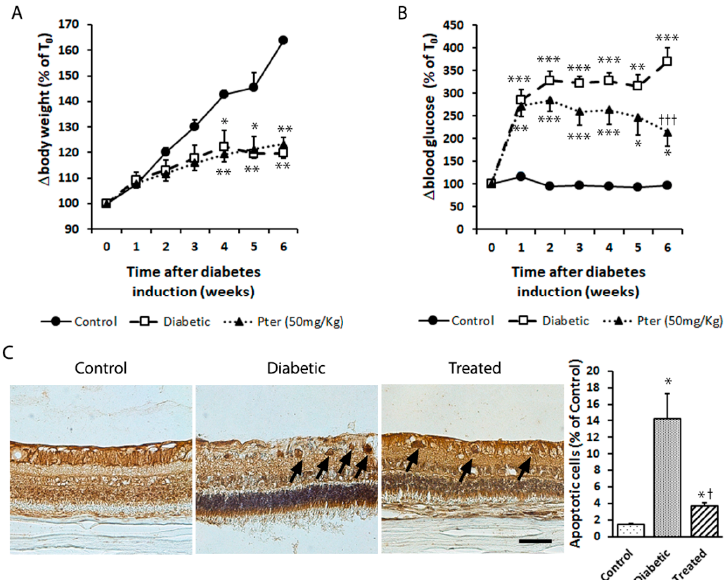
Figure 1. Chemical structures and plasma levels of Pter after administering Pter phosphate disodium salt. The pharmaceutical form of disodium salt of Pter phosphate was used to facilitate its daily subcutaneous administration in vivo. ( A ) Chemical structures of Pter and Pter phosphate disodium salt. ( B ) A subcutaneous injection of Pter phosphate disodium salt (Pter 50 mg/kg) was administered dissolved in water (25 mg/mL). Blood was collected at different times and Pter was quantified in